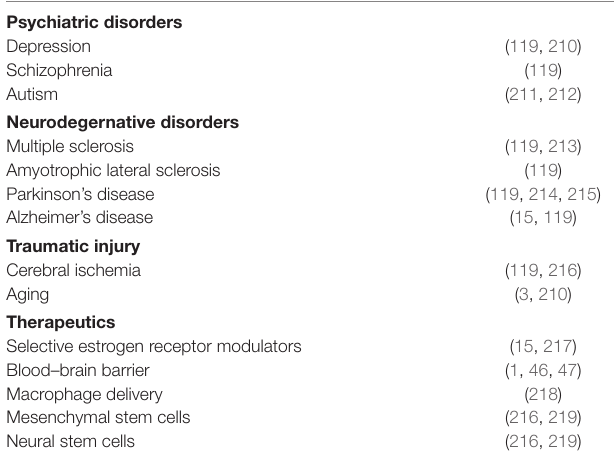
TABLe 1 | Neurological disorders with known inflammatory component and